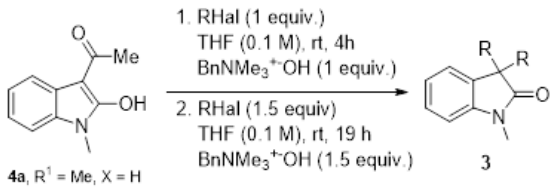
Figure 4 - DaA in the generation of 3,3-disubstituted oxindole 3